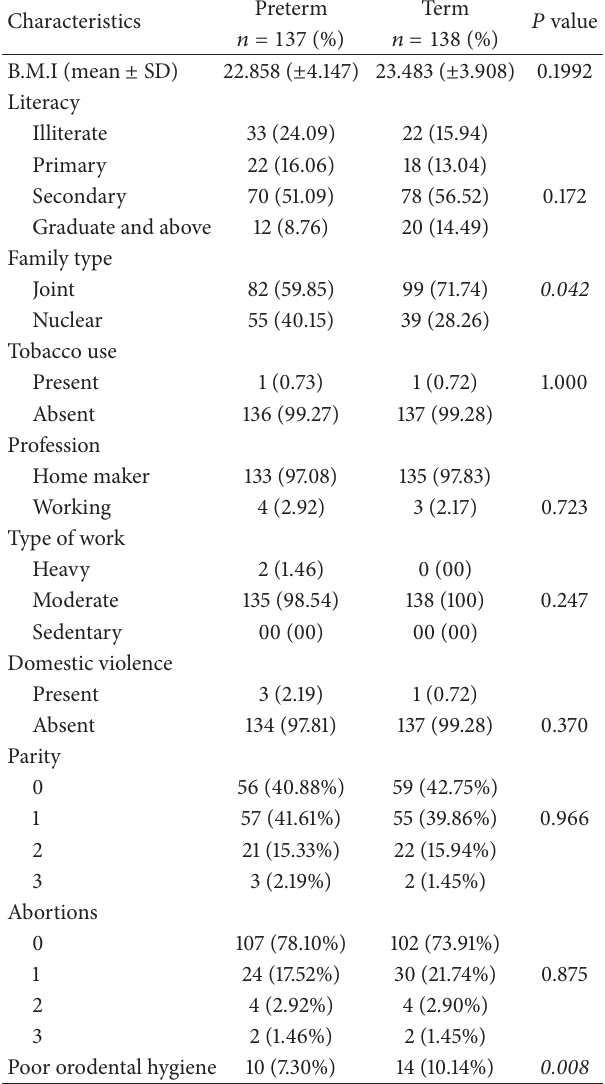
Table 1: Population characteristics in both the